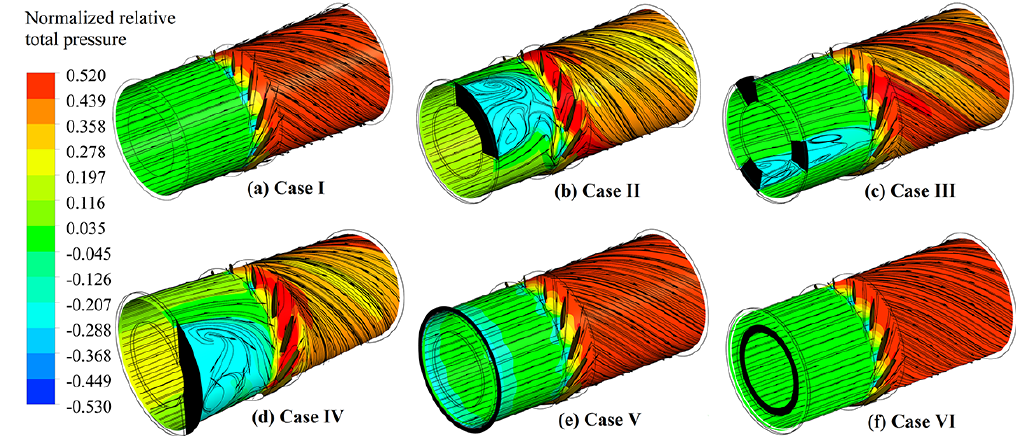
Figure 11. Normalized relative total pressure contours and streamlines on 80% span circumferential plane at near stall condition.